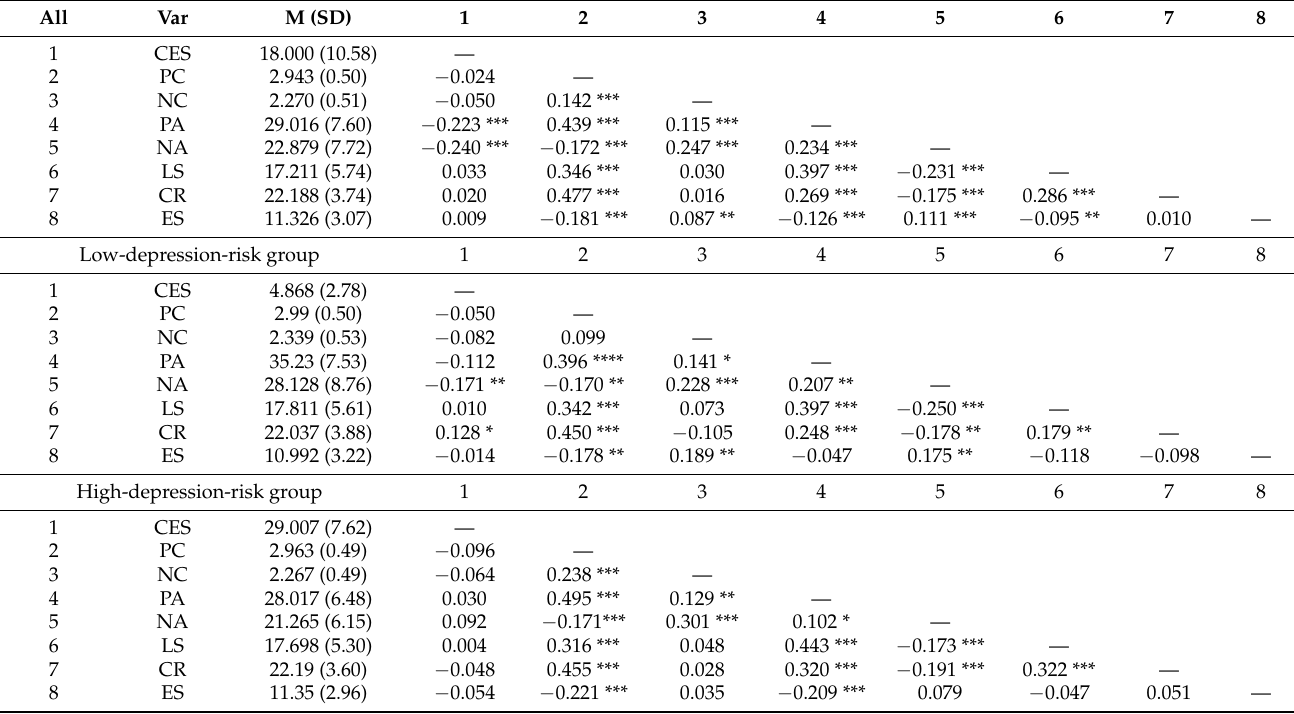
Table 2. The Correlation among all